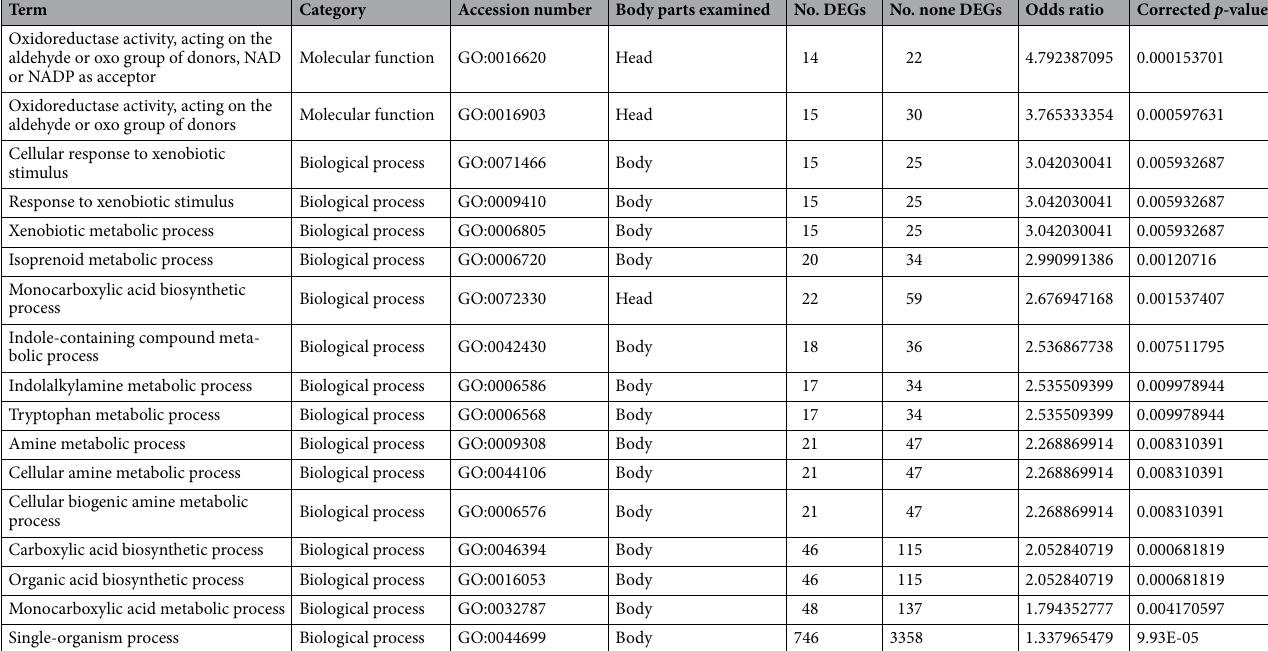
Table 2. Gene Ontology (GO) terms specifically observed during the worker-presoldier molt.